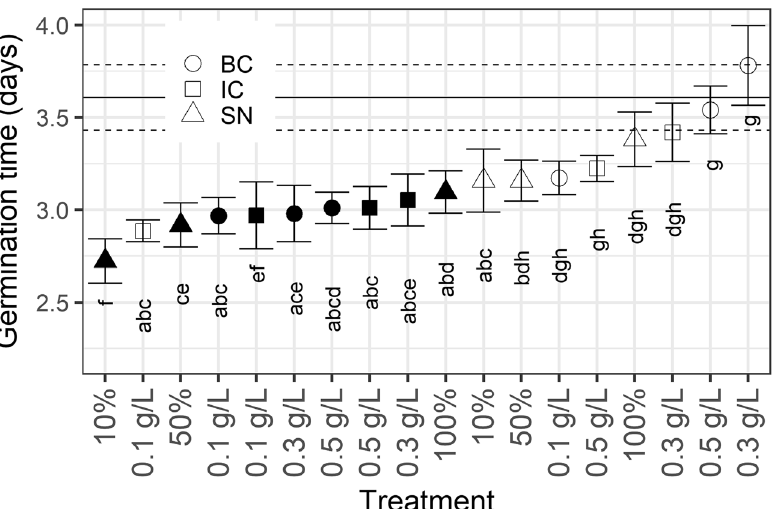
Figure 1. Germination times (in days) of tomato seeds. Shapes indicate mean of the 100 seeds for each treatment, filled shapes indicate C. vulgaris (13–1), open shapes indicate S. obliquus (B2–2). IC squares, BC circles, SN triangles. Letters below shapes indicate group belonging, within which no significant difference at the 0.05 level could be found (Kruskal–Wallis rank sum test with Conover’s post hoc test). Mean of the control group is indicated by the horizontal line, and its group adherence is “g”. Error bars indicate ± s.e.m. (in the case of control value indicator, ± s.e.m. is indicated by dashed horizontal